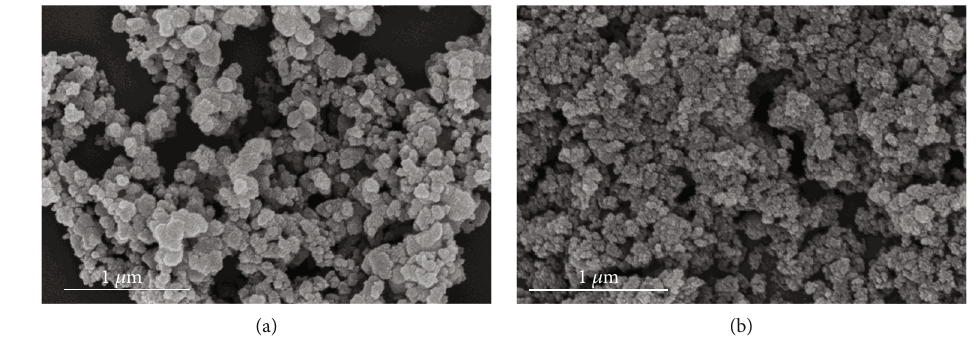
Figure 2: SEM images of vernadite: (a) Ver-H and (b) Ver-OH.